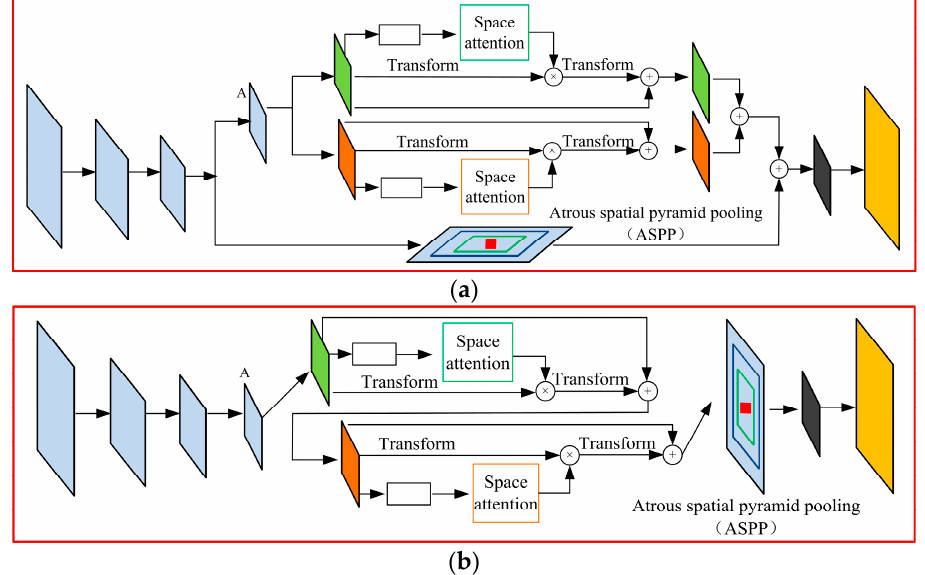
Figure 5. Double attentional network structure:( a ) parallel network structure, and ( b ) series network structure.